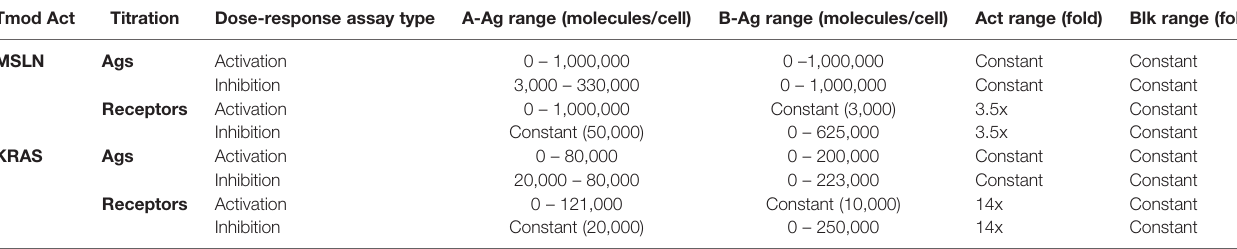
Values are estimated from surface expression measurements and standard curves. For receptor titration experiments with MSLN Tmod, wildtype [i.e., MSLN(+)] Hela cells were used that express ~50,000 MSLN molecules/cell (see Supplementary Figure 5B ). For KRAS Tmod experiments, T2 cells that stably express A*11were used, and 50 m M NY-ESO-1 peptide was added to stabilize transfected A*02 expression on the cell surface (see